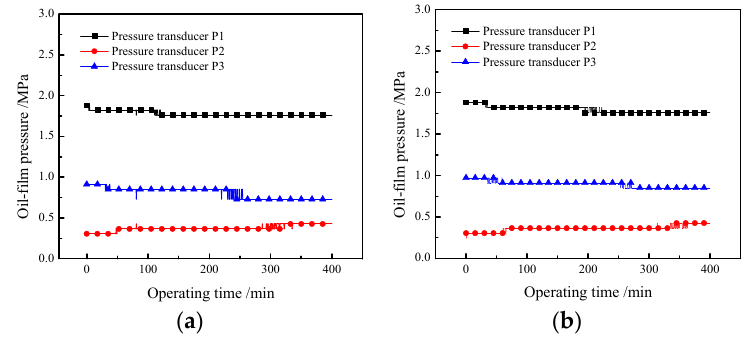
Figure 10. Comparison of oil ‐ film pressure between S220 and M220 at 150 rpm ‐ 6 MPa. ( a ) S220; ( b ) M220.